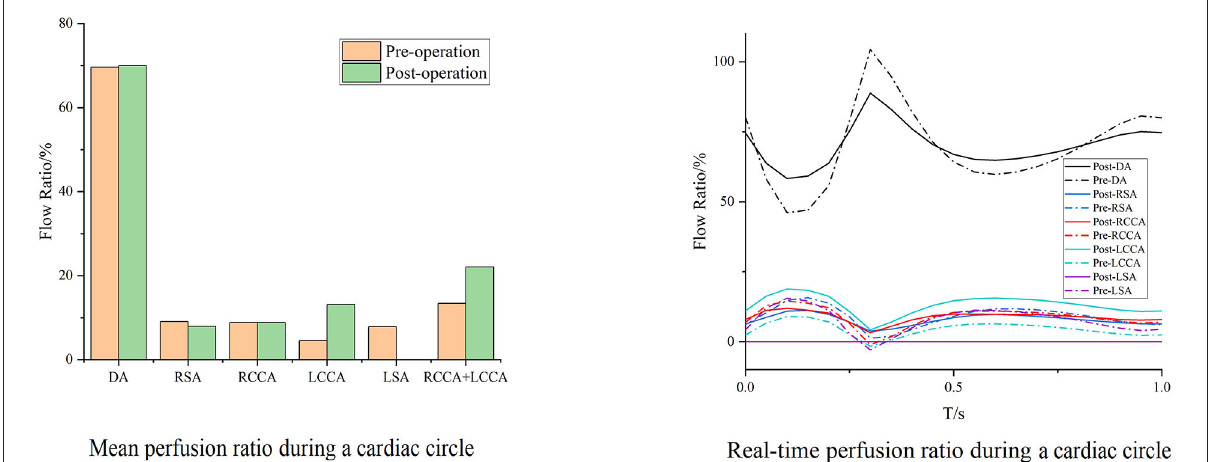
FIGURE7 Blood flow perfusion ratios of branches in Case 3. The bar graph illustrates the changes in the flow perfusion ratios in different branches. The curve figure illustrates the real-time perfusion within a cardiac cycle. Curves below the 0 level indicate backflow. DA, descending aorta; LCCA, left common carotid artery; RCCA, right common carotid artery; LSA, left subclavian artery; RSA, right subclavian artery.